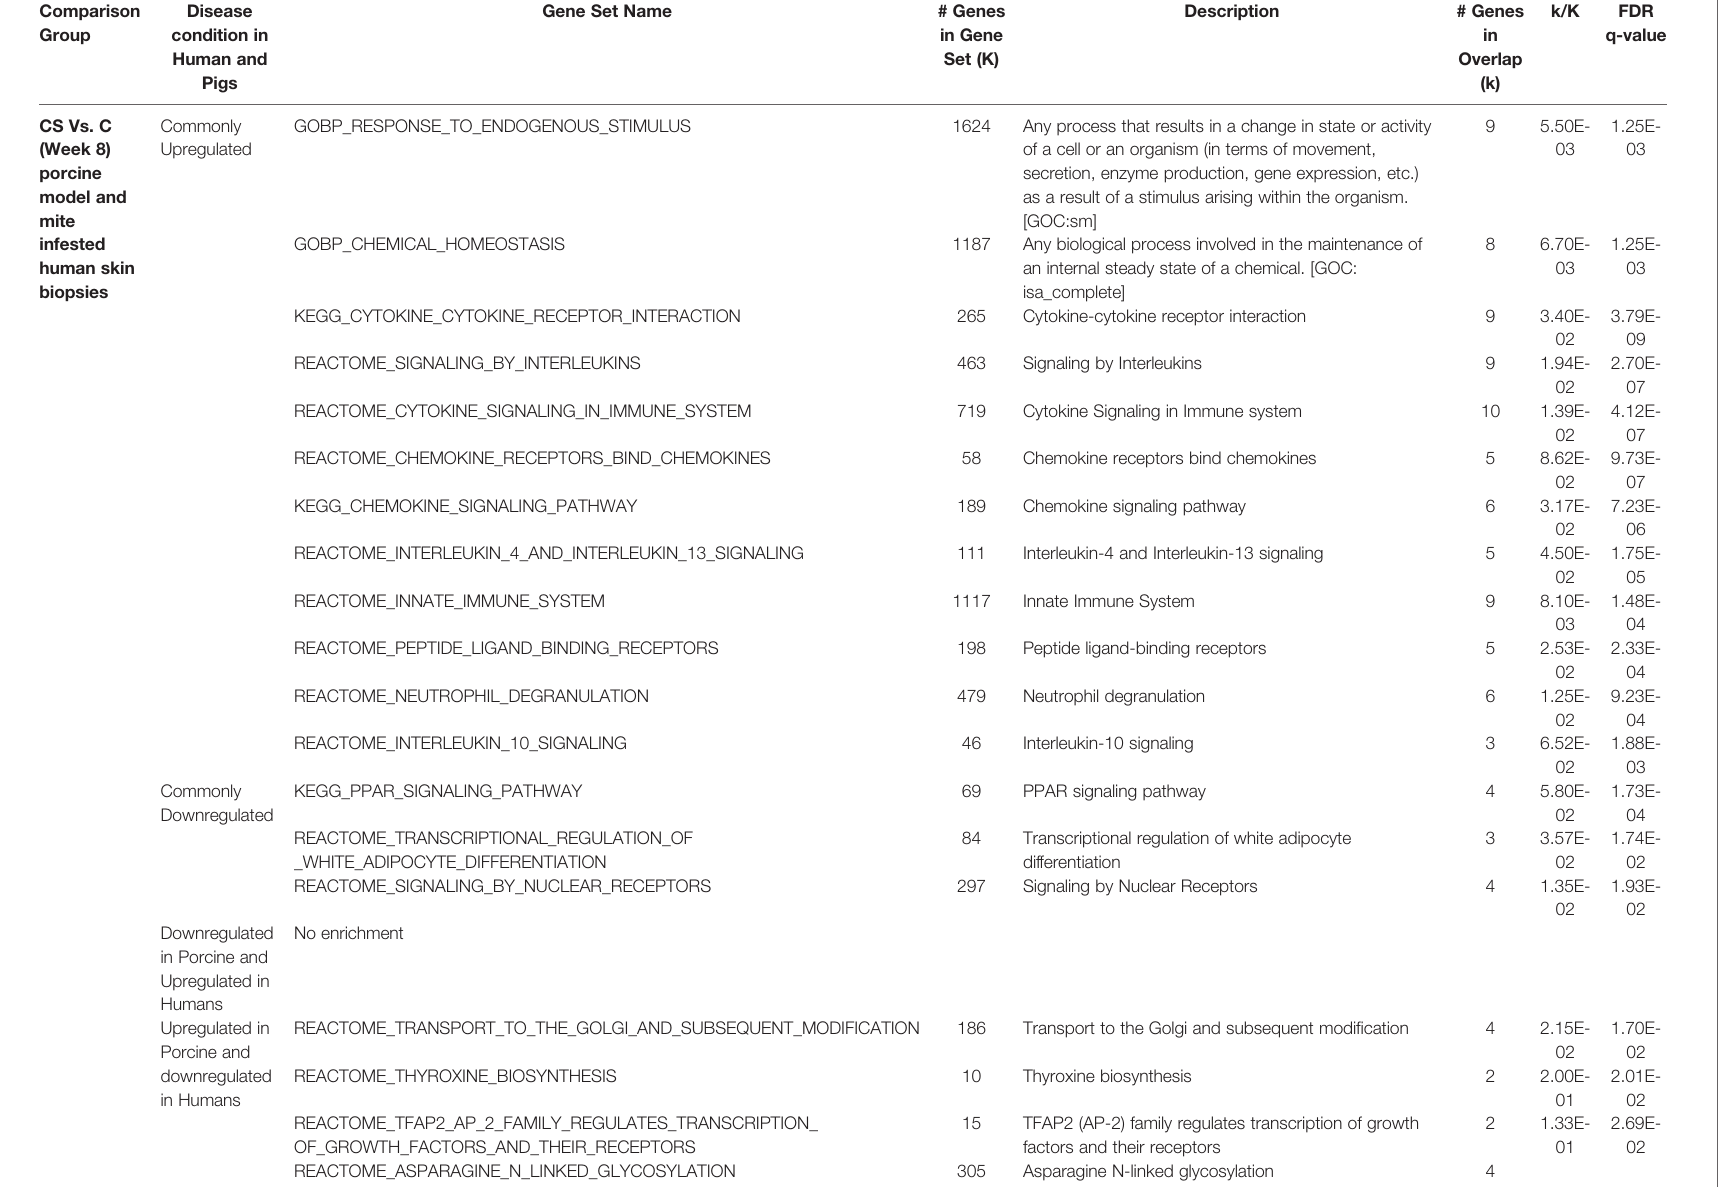
TABLE 3 | KEGG pathway enrichment of common genes in mite-infested human (Scabies vs. control) and porcine groups (Week 8; CS vs . OS and CS vs . C). Comparison Group